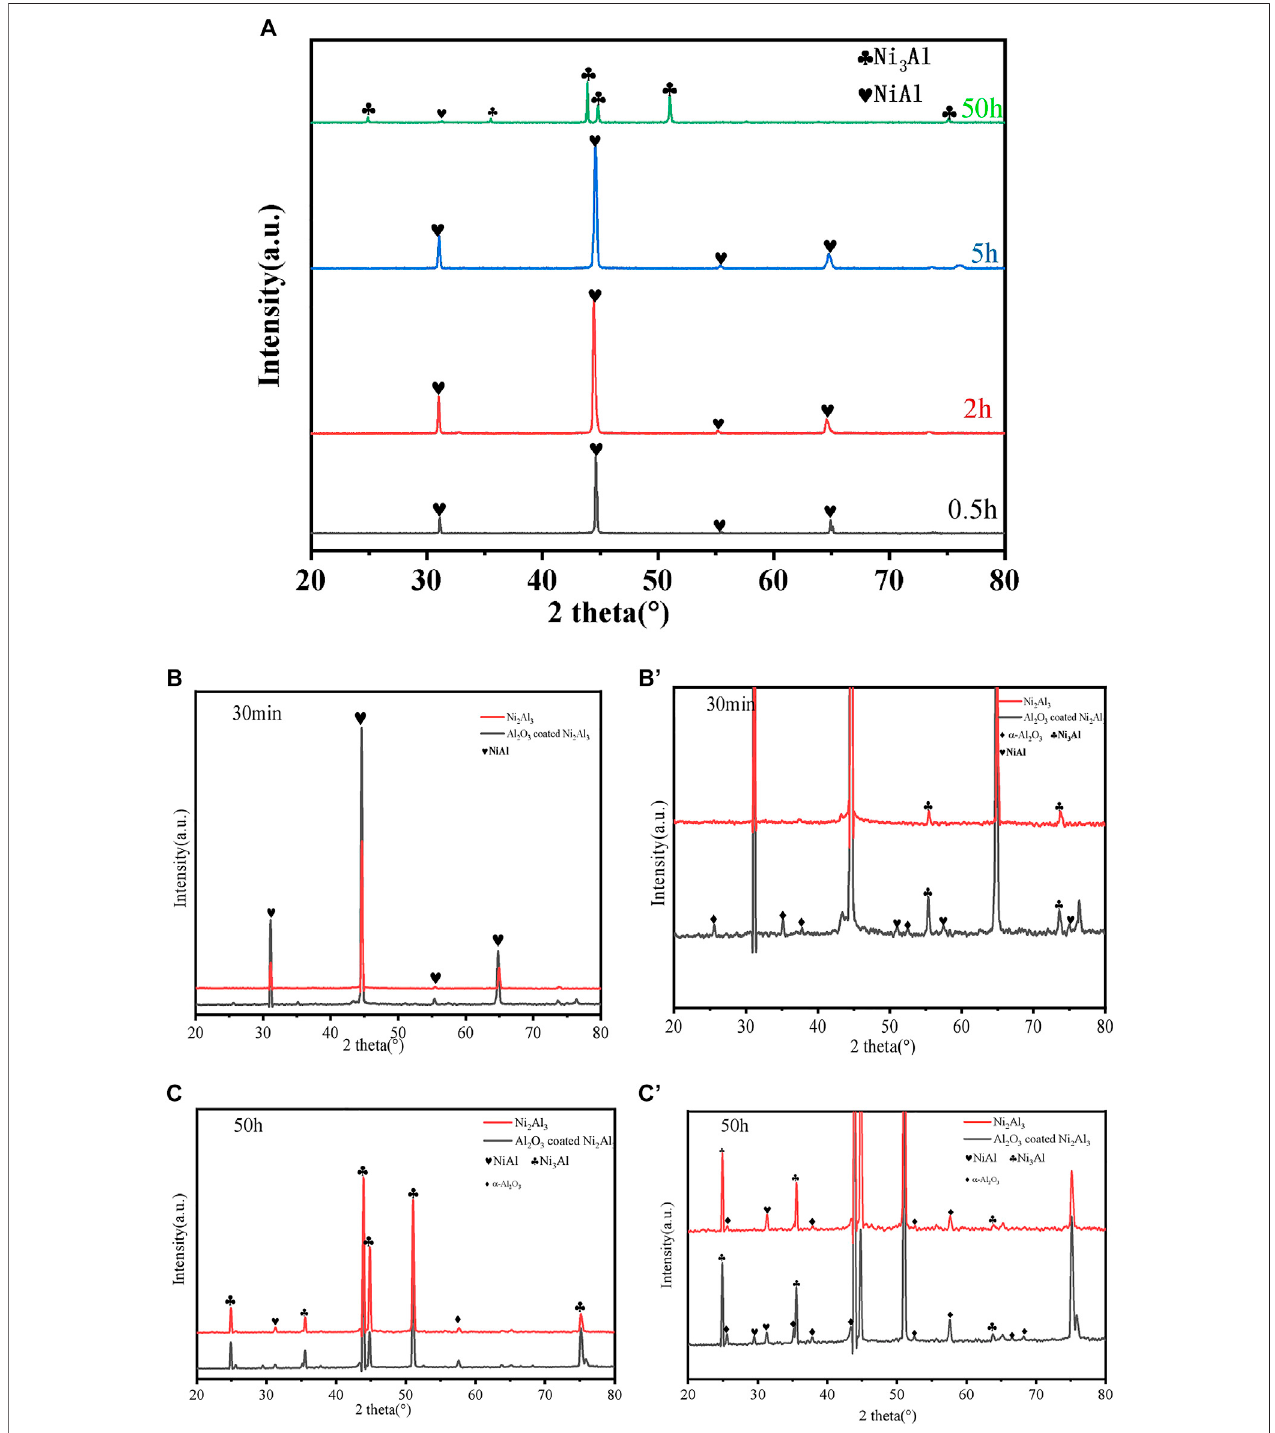
FIGURE5| XRDpatternsof (A) Ni 2 Al 3 coatingatdifferenttimesand (B) and (C) 30 minand50 hnakedandtheAl 2 O 3 fi lm – coveredNi 2 Al 3 coatingafteroxidationin the air at 1,000 ° C and (B 9 ) (C 9 ) locally magni fi ed.